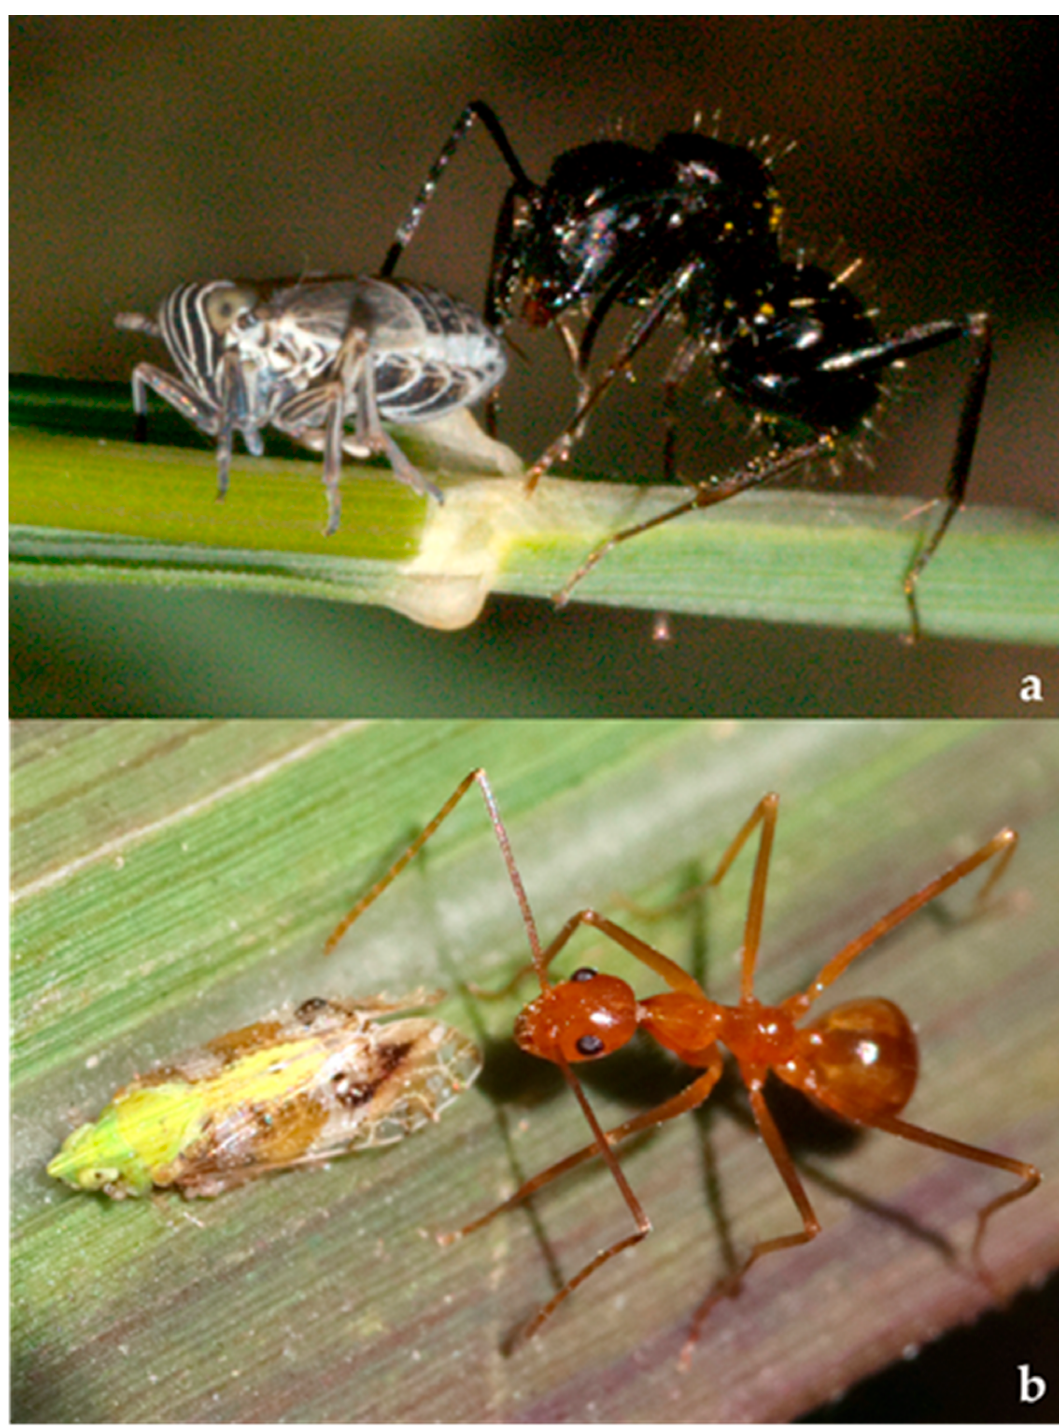
Figure 5. Delphacidae: ( a ) Dicranotropis beckeri Fieber, 1866 tended by Formicidae: Formicinae: Cam-